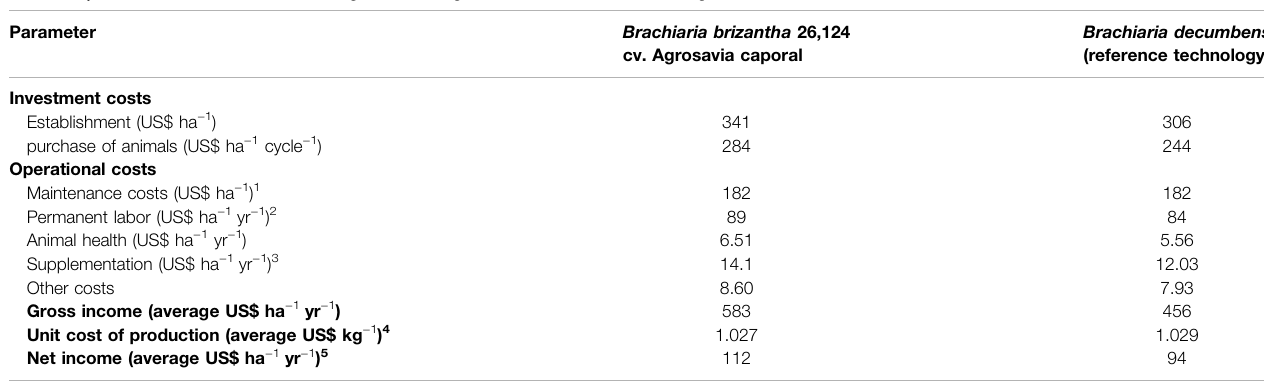
TABLE 5 | Costs and income for cattle raising and fattening under both evaluated technologies.